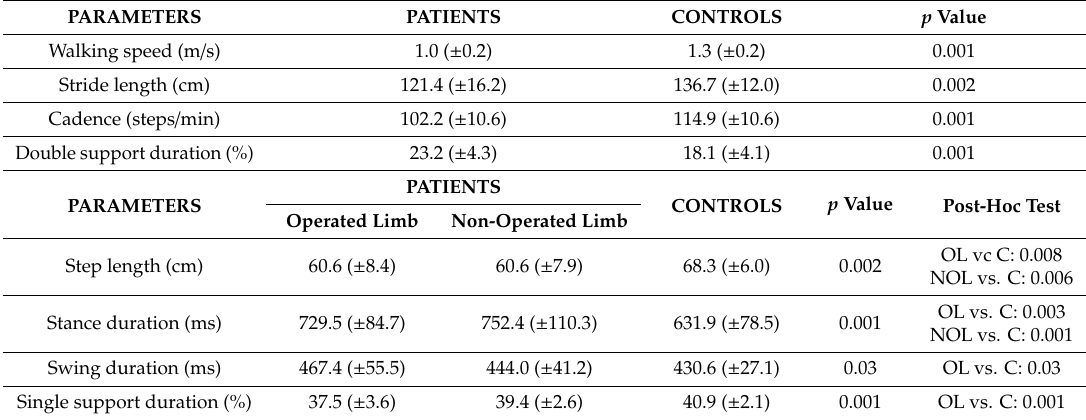
Table 1. Spatiotemporal parameters of gait at self-selected speed. Mean ( ± standard deviation) values are reported. OL: operated limb. NOL: non-operated limb. C: